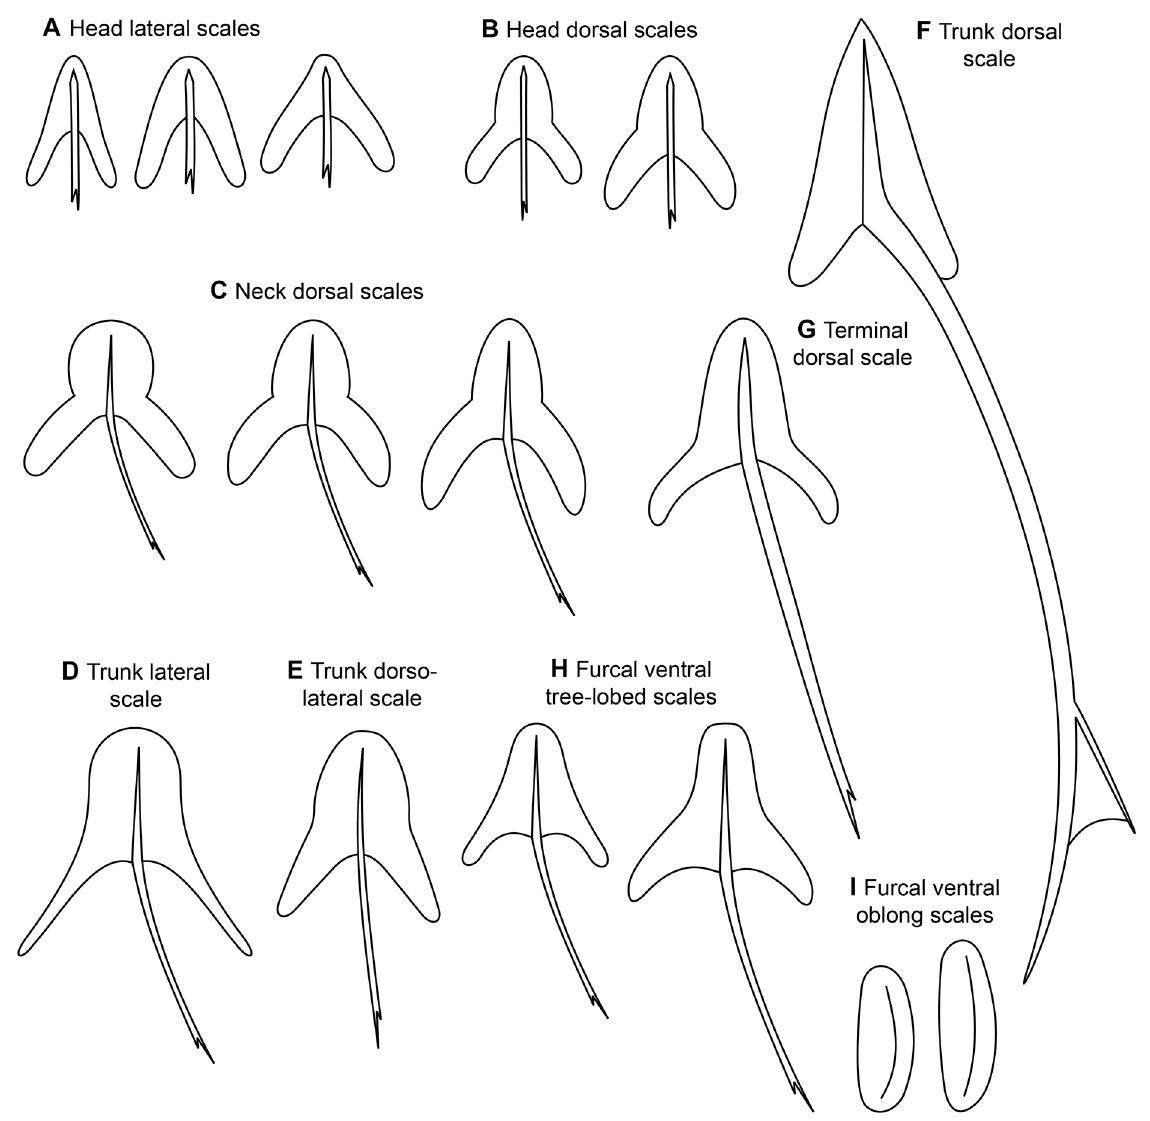
Fig. 11. Scales of Chaetonotus ( Hystricochaetonotus ) mirabilis sp. nov. A . Head lateral scales. B . Head dorsal scales. C . Neck dorsal scales. D . Trunk lateral scale. E . Trunk dorsolateral scale. F . Trunk dorsal scale. G . Terminal dorsal scale. H . Furcal ventral three-lobed scales. I . Furcal ventral oblong